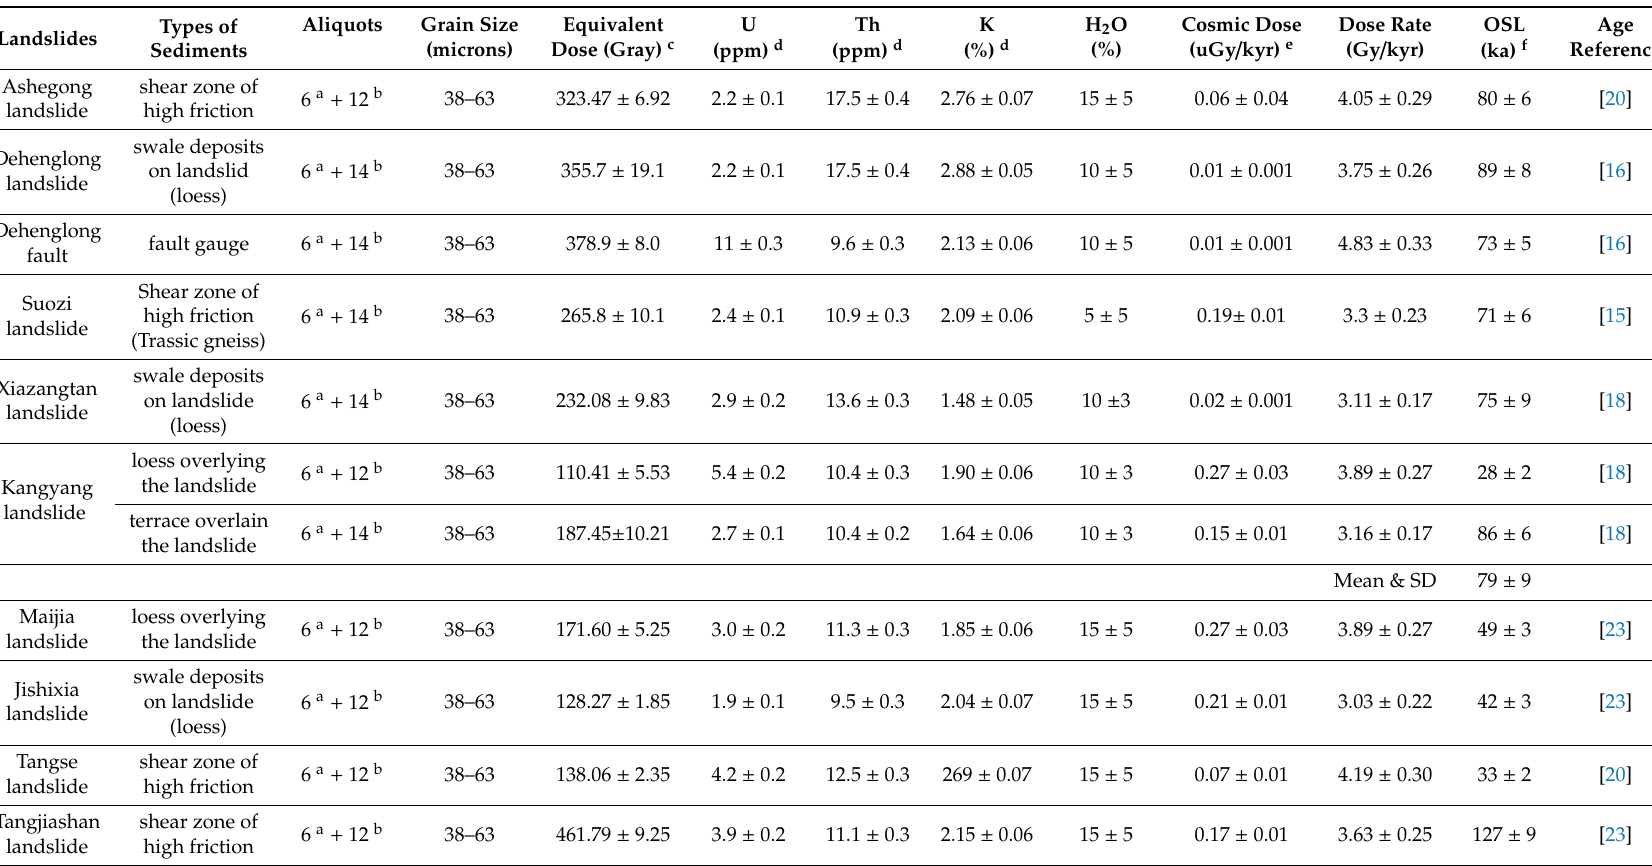
Table 2. OSL ages on quartz grains of sediments associated with landslides from Longyang Gorge to Liujia Gorge on northeast Tibetan Plateau.